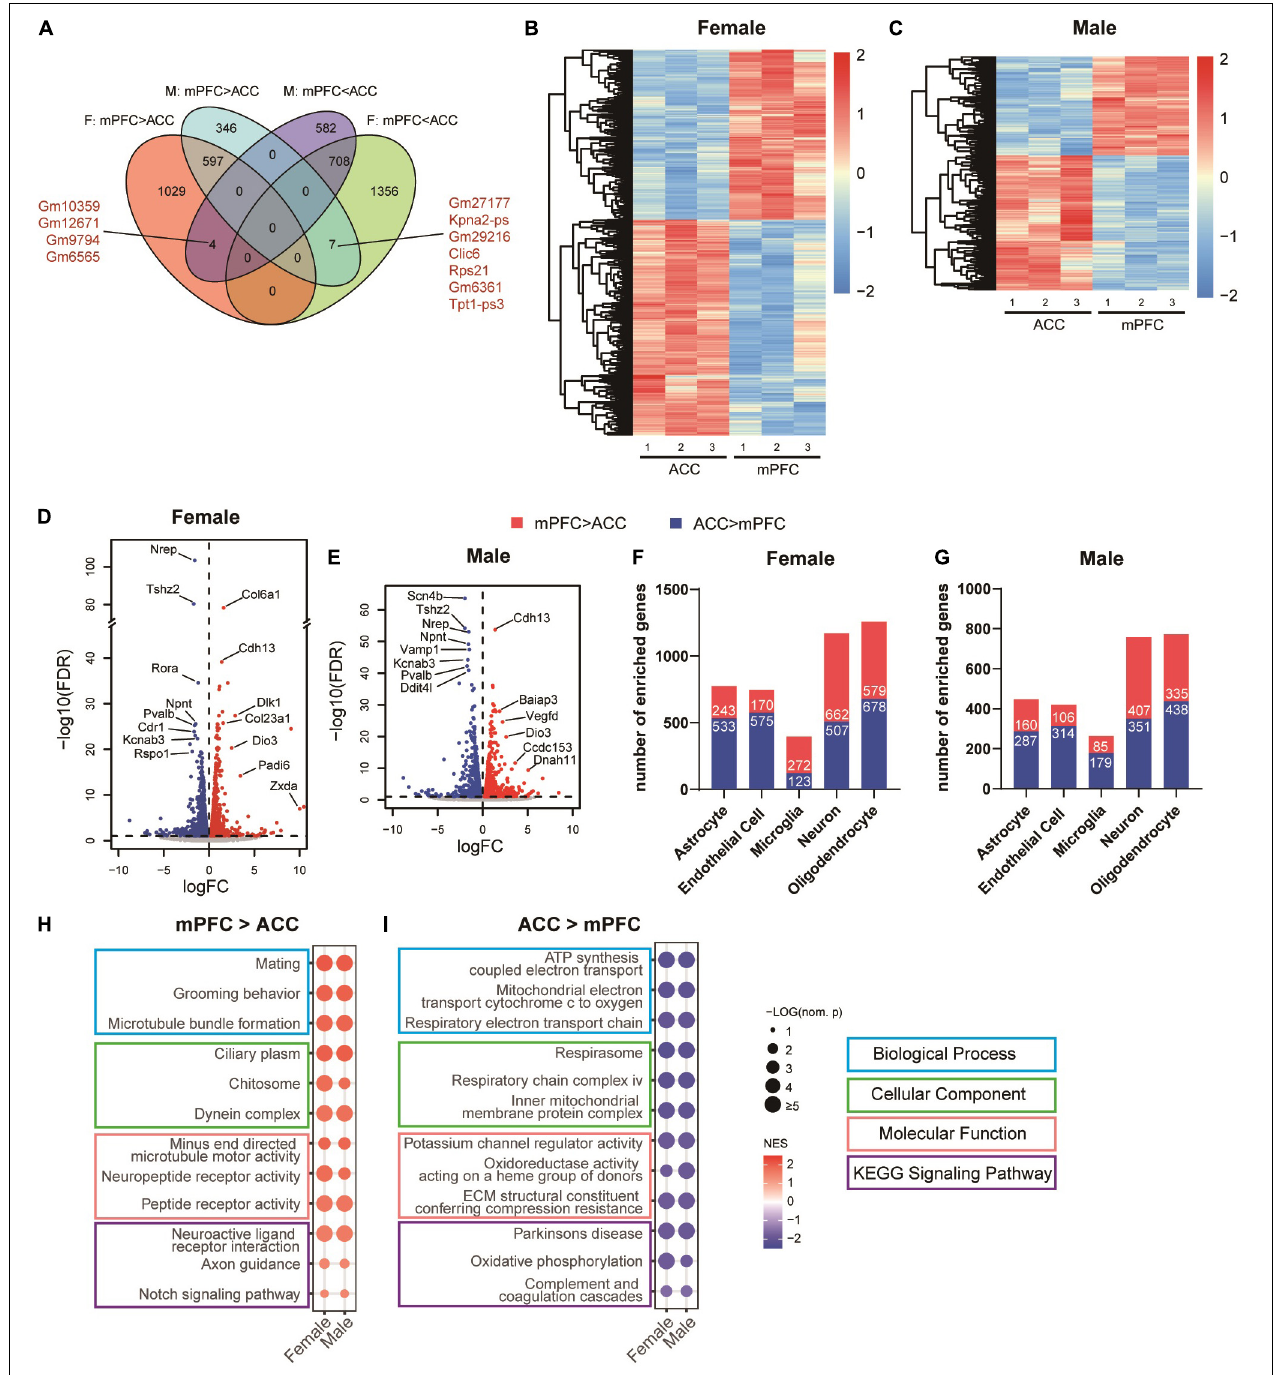
FIGURE 7 | Differences between the transcriptomic profiles of the mPFC versus the ACC of female and male mice in the sham group. (A) Venn diagram depicting partial overlaps of the DEGs comparing the mPFC versus the ACC between the female and male mice. F, female; M, male. mPFC > ACC: transcripts expressed significantly more in the mPFC than in the ACC; mPFC < ACC: transcripts expressed significantly more in the ACC than in the mPFC. Hierarchical clustered heatmaps showing relative expression of the DEGs comparing the ACC versus the mPFC in the female (B) and male (C) mice from the sham group. Color scales represent standardized rlog-transformed values across samples. The volcano plots of the DEGs in the female (D) and male (E) mice, with horizontal lines at the –log 10 (false discovery rate, FDR) = 1 and vertical lines at log 2 (fold change, FC) = 0. Blue dots represent transcripts expressed significantly more in the ACC than the mPFC, and the red dots represent transcripts expressed significantly more in the mPFC than the ACC. The numbers of DEGs enriched in different cell types in the female (F) and male (G) mice, comparing the mPFC versus the ACC. Top differentially enriched gene sets in the mPFC (H) versus the ACC (I) . The size of the dots indicates the –log 10 (nominal p ) values, and the color indicates the normalized enrichment scores